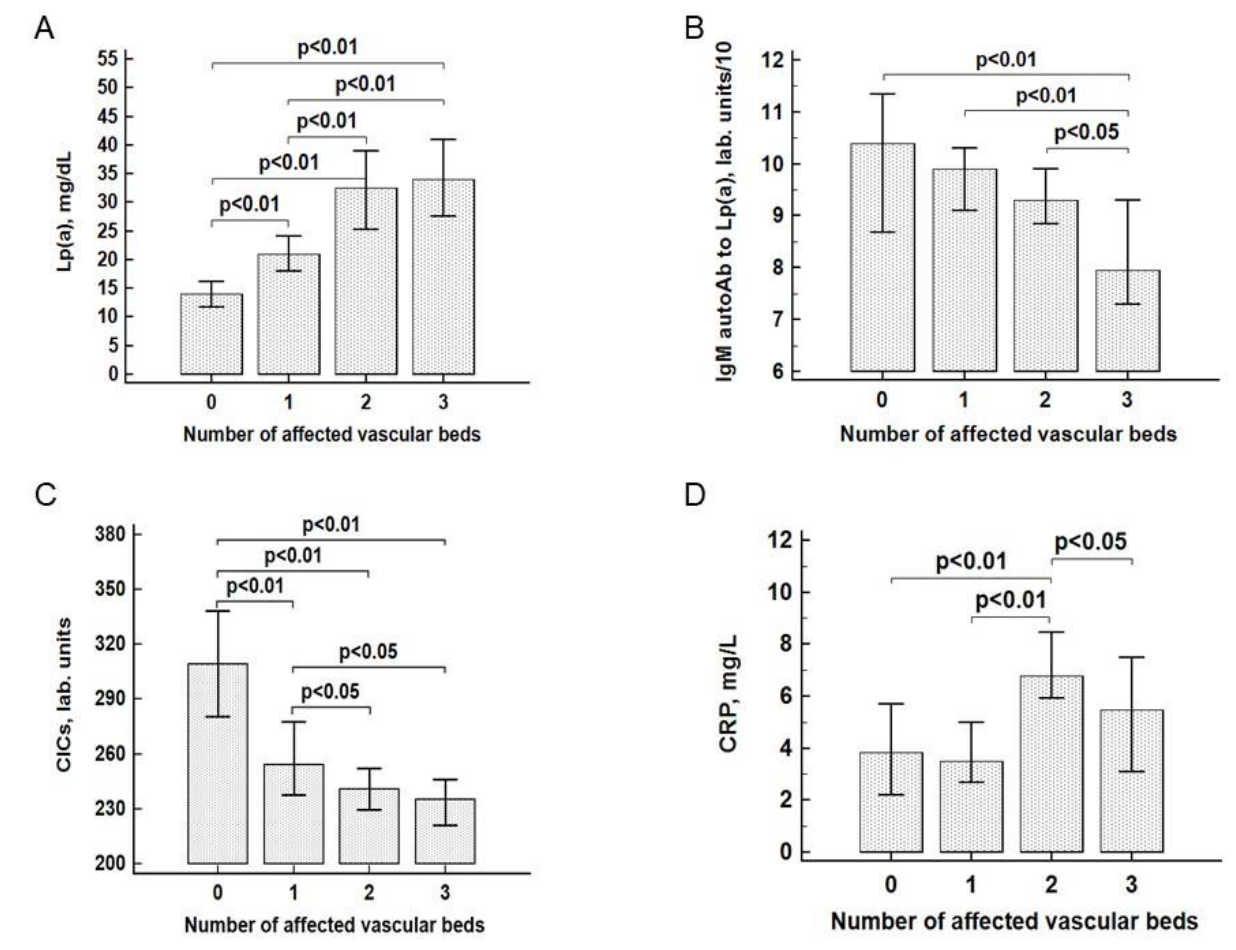
Figure 1. ( A ) The levels of lipoprotein(a). ( B ) IgM autoantibodies to lipoprotein(a) (the levels of specific autoantibodies against Lp(a) and LDL were determined in the serum of 512 randomly selected representative patients: group 0, n = 72; group I, n = 153; group II, n = 183; group III, n = 104). ( C ) Circulating immune complexes. ( D ) C-reactive protein, depending on the number of affected vascular beds. Data are presented as the median and 95% confidence interval. Lp(a): lipoprotein(a), CICs: circulating immune complexes, CRP: C-reactive protein, autoAb: autoantibody .